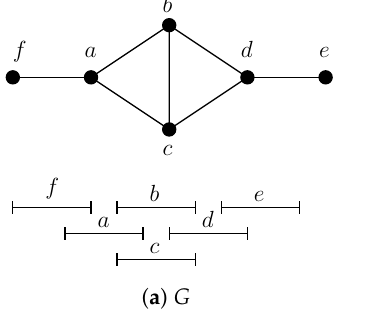
Figure 12. A unit interval G and its twin graph G 1